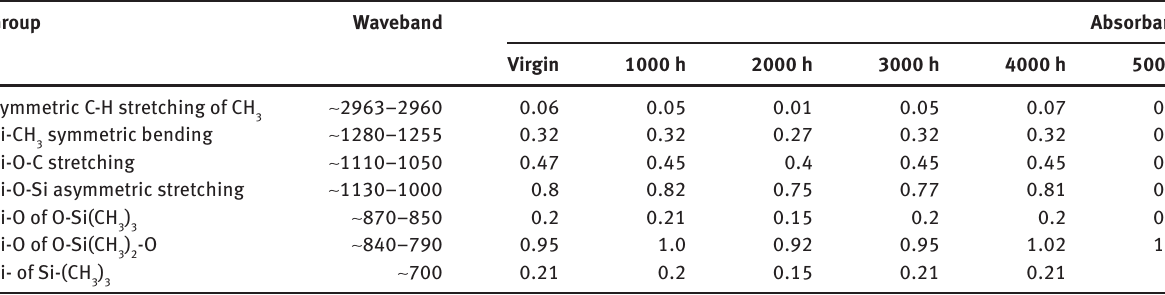
Table 6: Absorption peaks in SNC-5 from virgin to 5000 h.